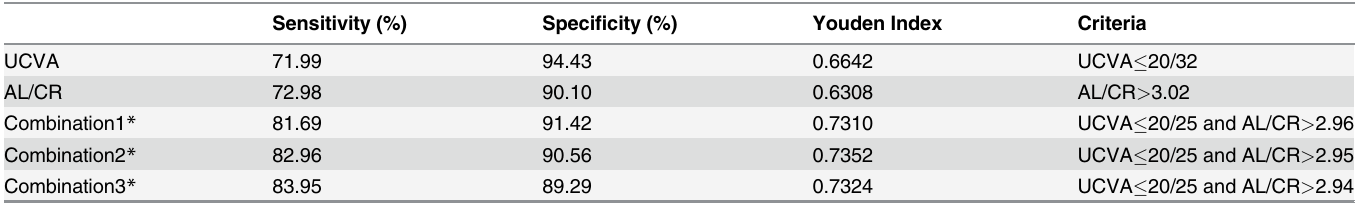
Table 6. Sensitivity, speci fi city, and criteria for UCVA, AL/CR, and combined use of UCVA and AL/CR when speci fi city is set to 90% (N = 3922). Sensitivity